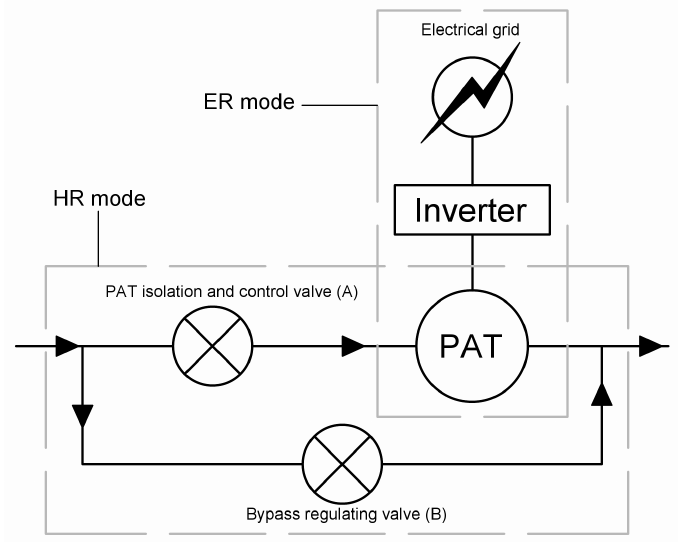
Figure 1. Installation scheme of a PAT with hydraulic or electrical regulation.